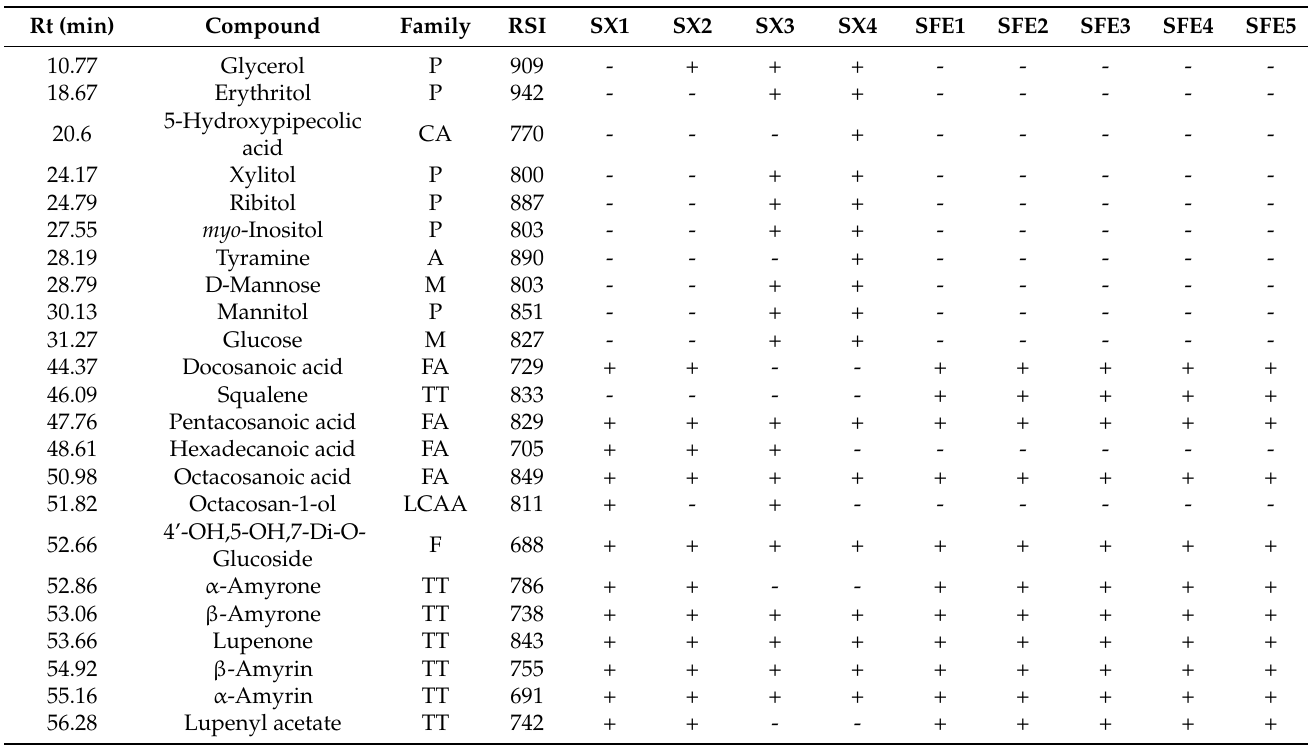
Table 2. List of identified compounds and respective retention times and reverse match factors (RSI) for all Soxhlet and SFE